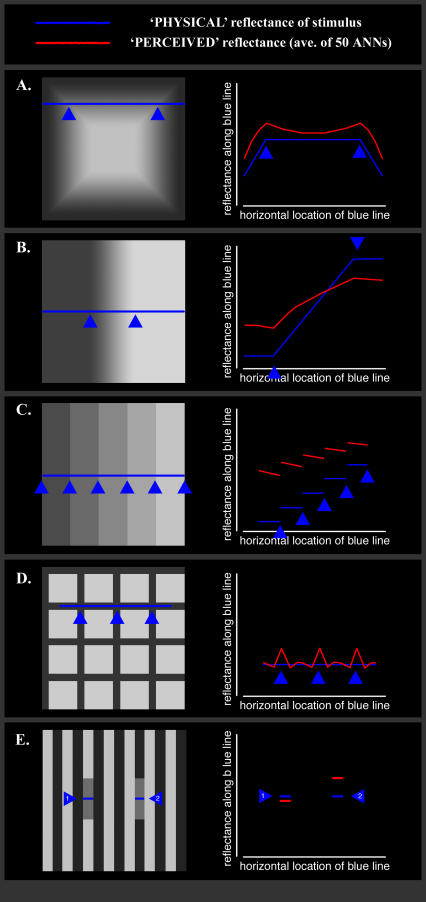
Artificial Neural Network Responses to Optical Illusions(A) Vasarely illusion stimulus on left. Note the illusory regions of lightness along the diagonals formed by the corners of the concentric squares. Blue line on right indicates the intensity profile at the corresponding points of the blue line on the left. Red line shows the relative reflectance predicted by the networks. Units are arbitrary and so are not plotted throughout this figure.(B) Mach band stimulus consisting of a dark bar (left) and a light bar (right) with a linear gradient between. Blue line on right indicates the intensity profile at the corresponding points of the blue line on the left. Red line shows the relative reflectance predicted by the networks.(C) Chevreul illusion stimulus, with five bars of uniform reflectance. Blue line on right indicates the intensity profile at the corresponding points of the blue line on the left. Red line shows the relative reflectance predicted by the networks.(D) Hermann grid illusion stimulus. Blue line on right indicates the intensity profile at the corresponding points of the blue line on the left. Red line shows the relative reflectance predicted by the networks.(E) White's illusion on left. The grey areas indicated have the same physical reflectance, although the left-hand one appears darker than the other. The ANN response on the right corresponds to this human experience, with the first perceived reflectance (1) being darker than the second (2).